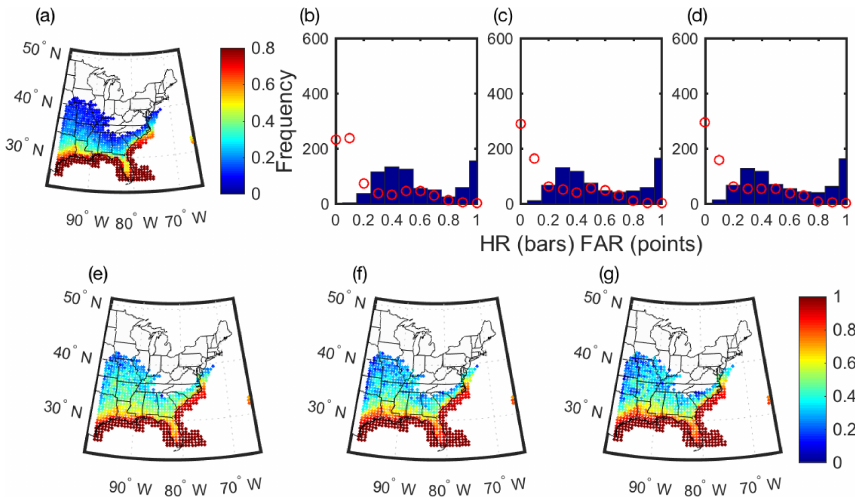
Figure 7. (a) Map of the fractional frequency of occurrence of minimum θ e > 337K in each grid cell based on the independent (test) data set. (b) Histogram of hit rate (HR) and false alarm rate (FAR) for all grid cells and (e) spatial map for correct identification of minimum θ e > 337K for all grid cells where this threshold is exceeded by > 8% of days in the independent data based on output from the multiple linear regression model (MLR). (c, f) As in panels (b) and (e) but for output from the ANN model with three hidden layers and including SM (ANN-HL3-SM). (d, g) As in panels (b) and (e) but for output from the ANN model with 3 hidden layers excluding SM